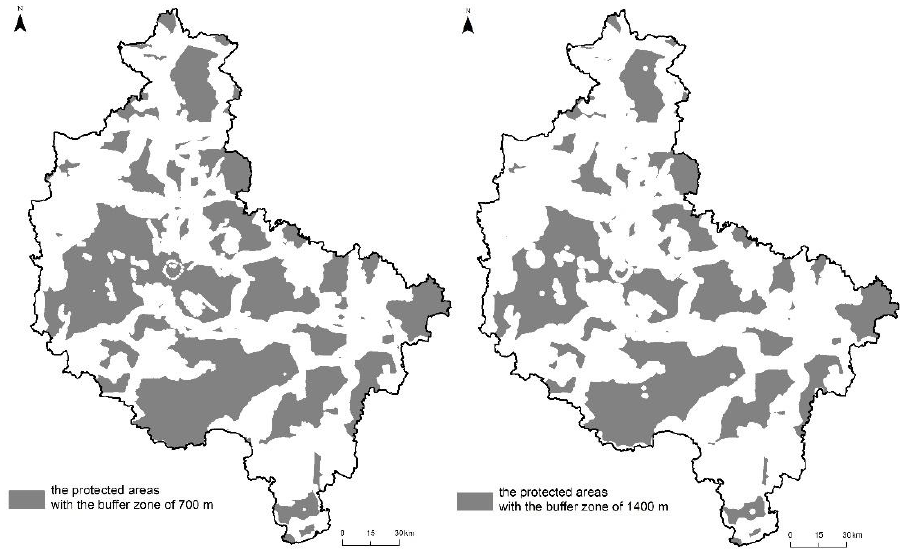
Figure 6. Area available for wind energy development — protected areas with the buffer zones of 700 m and 1400 m in the Greater Poland Voivodeship (own calculations).